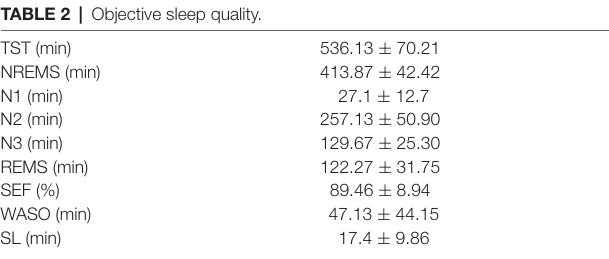
Frontiers in Human Neuroscience |